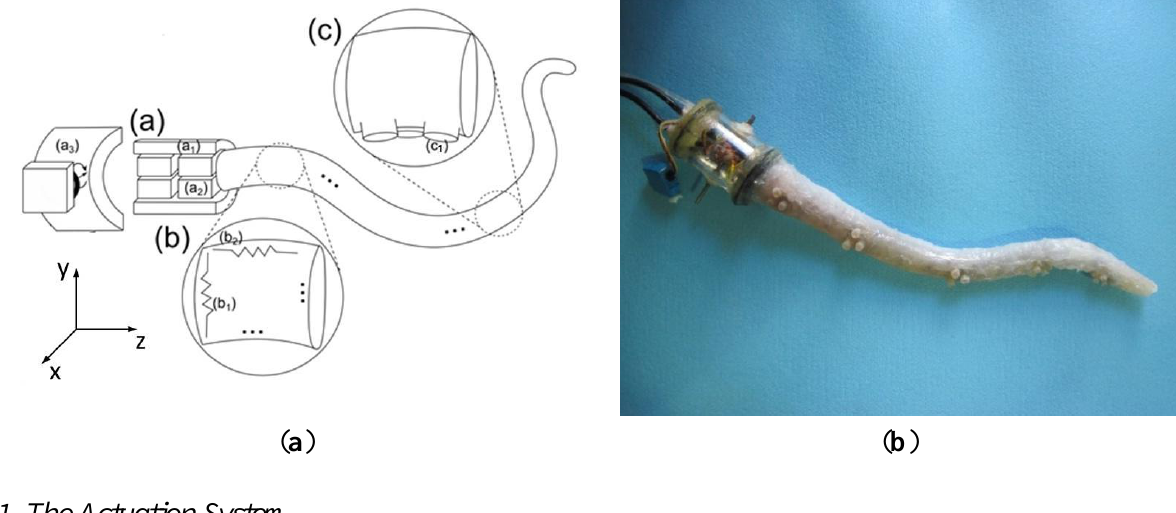
Figure 4. ( a ) General description of the octopus-like robotic arm: the ―shoulder‖ of the arm is composed of the cylindrical base (a1) that houses a DC motor (a2), and an external structure with a waterproof servomotor which can turn the base on the x axis (a3); in (b), a section with transverse (b1) and longitudinal (b2) SMAs are highlighted; in (c), the external skin with the passive suckers (c1) are shown; ( b ) The real